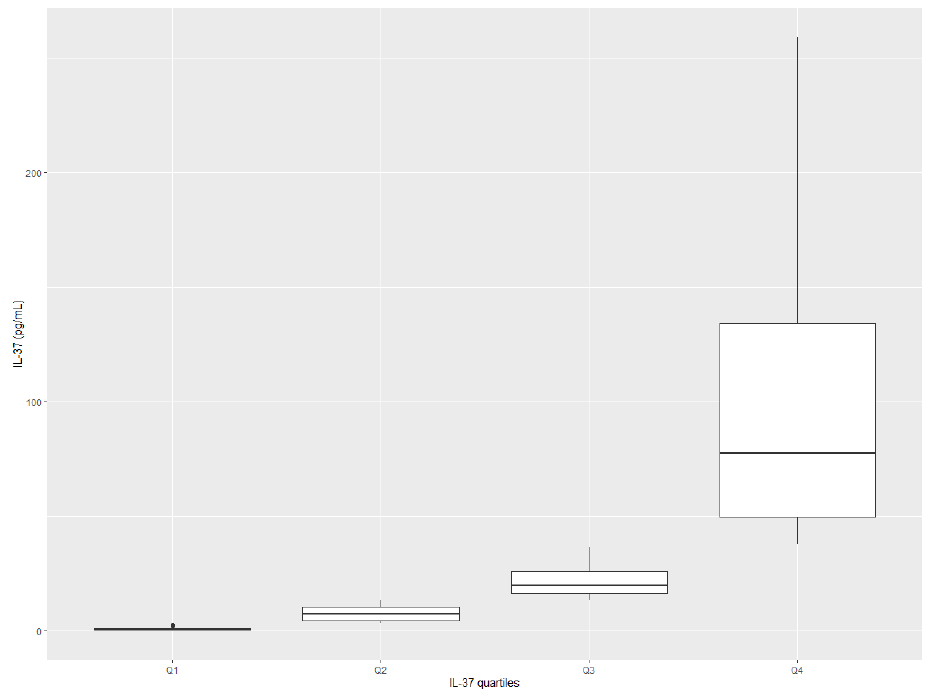
Figure 2. Distribution of IL-37 among participants (box-plot diagram).